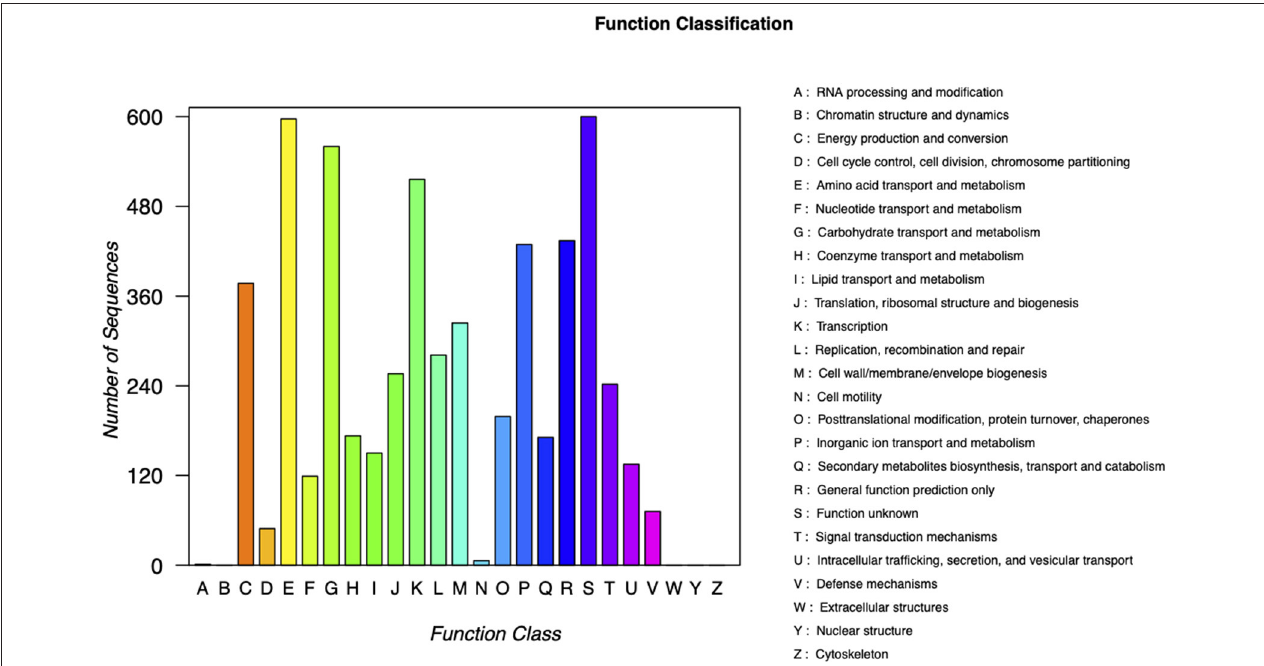
FIGURE 3 | Classification of COG functions of chromosome in DNA libraries. COG, Cluster of Orthologous